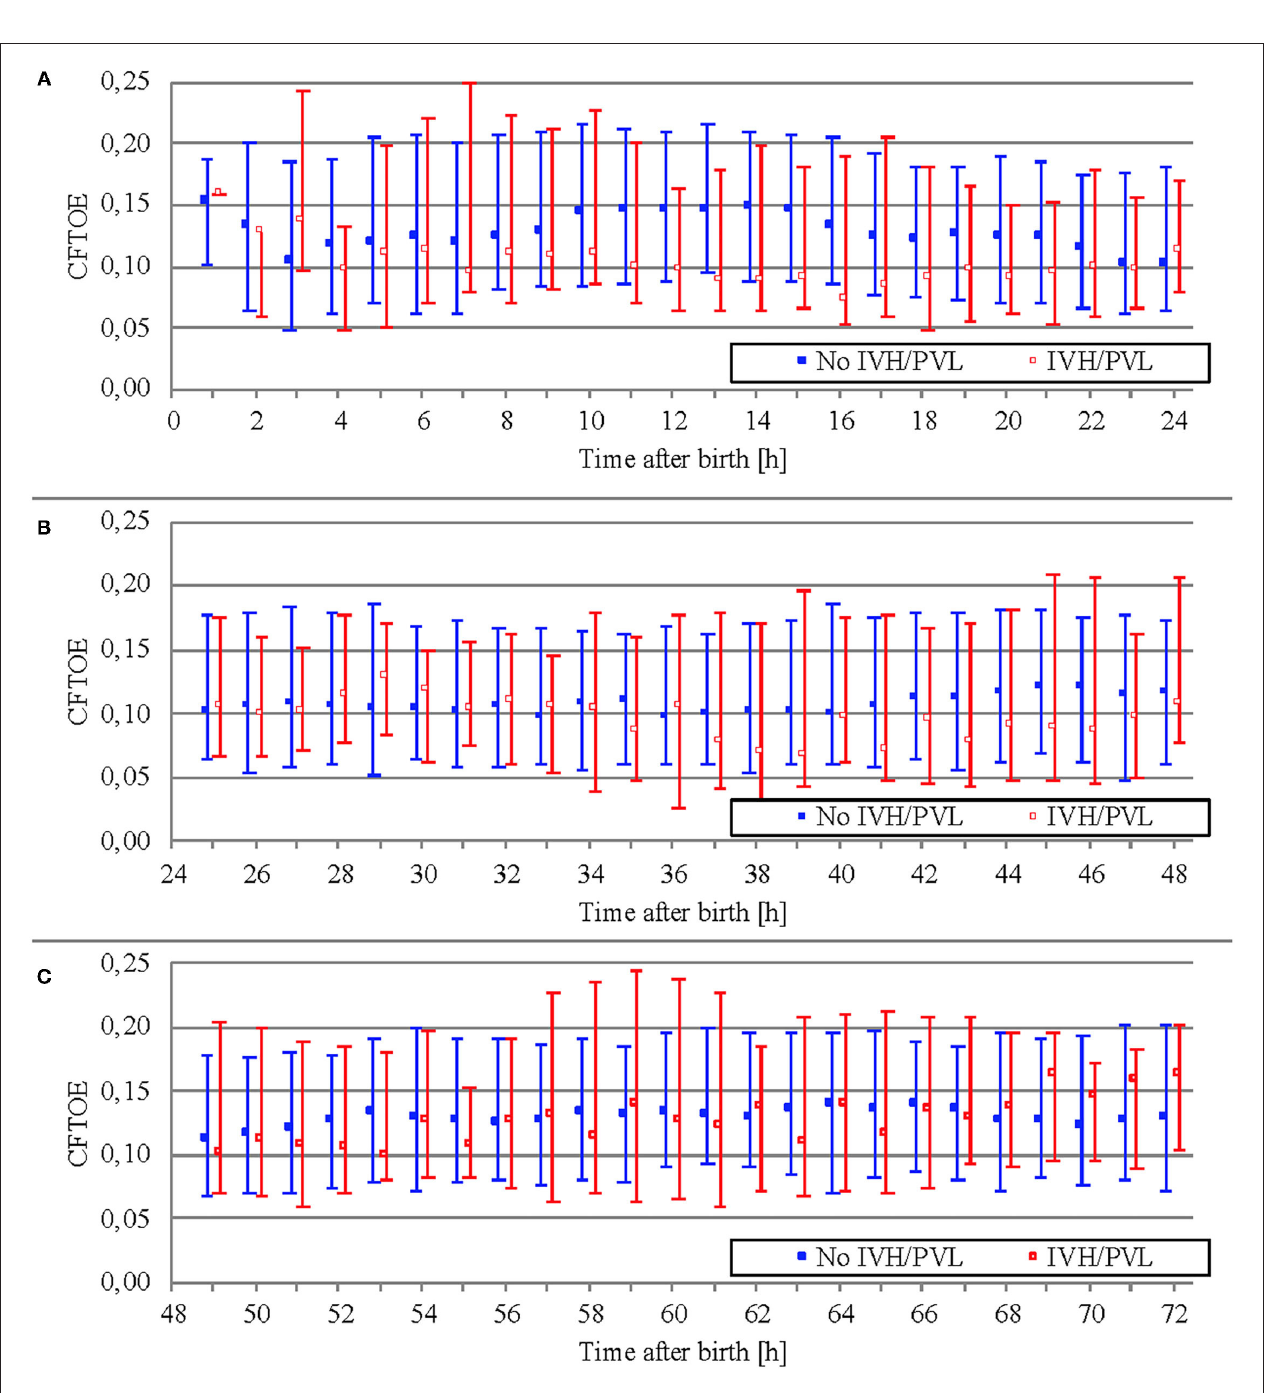
FIGURE 6 | Comparison of CFTOE (median and interquartile range over 1h) between outcome groups on the first day of life (A) , on the second day of life (B) , and on the third day of life (C) .